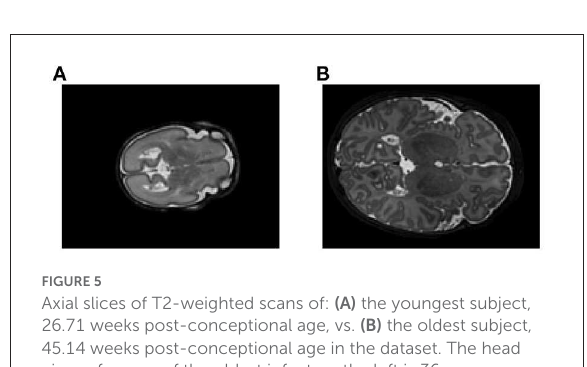
FIGURE5 Axial slices of T2-weighted scans of: (A) the youngest subject, 26.71 weeks post-conceptional age, vs. (B) the oldest subject, 45.14 weeks post-conceptional age in the dataset. The head circumference of the oldest infant on the left is 36 cm, compared to 21 cm of the youngest infant on the